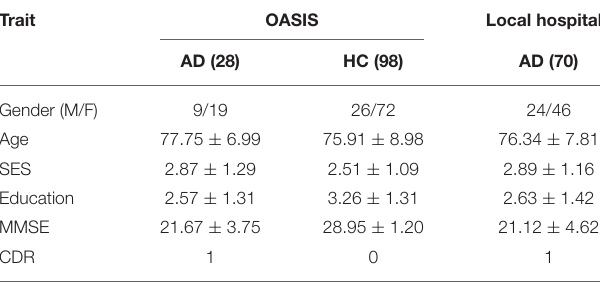
TABLE 1 | Demographics of dataset in this study. Trait